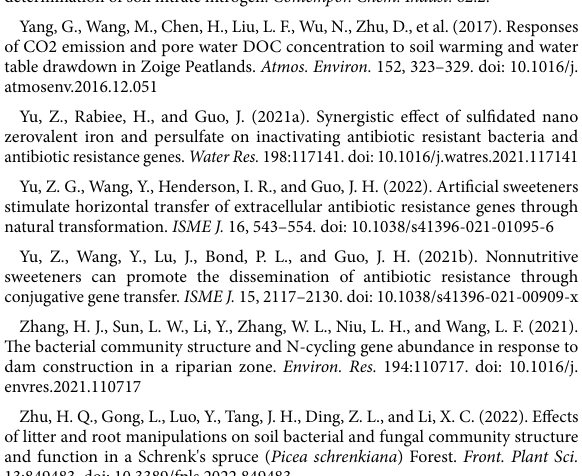
table drawdown in Zoige Peatlands. Atmos. Environ. 152, 323–329. doi: 10.1016/j. atmosenv.2016.12.051 Yu, Z., Rabiee, H., and Guo, J. (2021a). Synergistic effect of sulfidated nano zerovalent iron and persulfate on inactivating antibiotic resistant bacteria